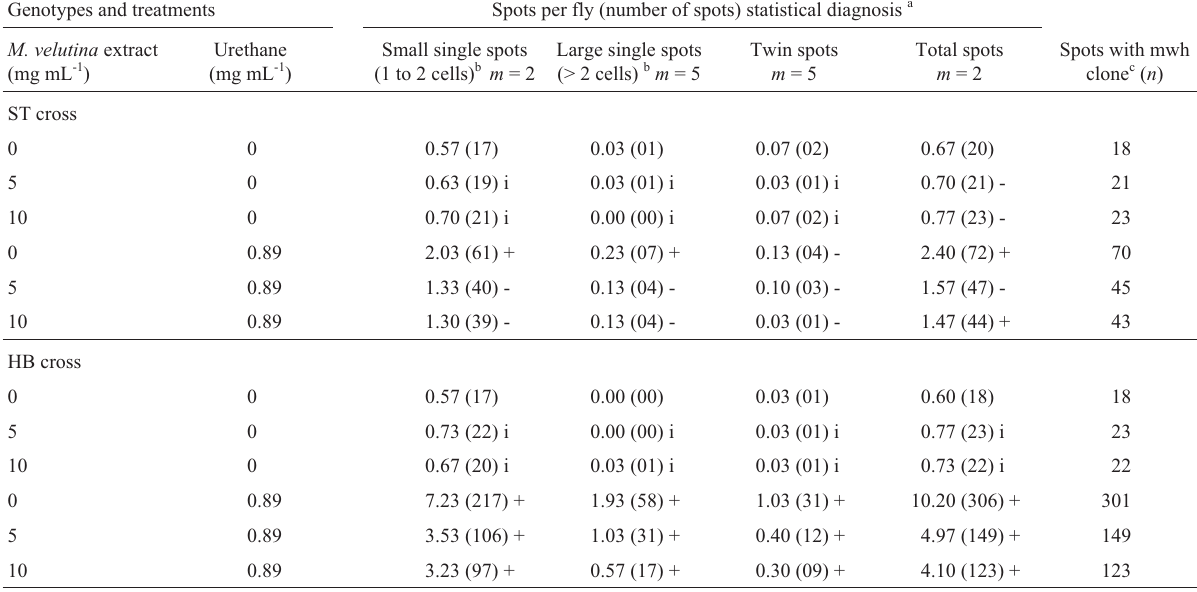
Table 2 - The D. melanogaster wing spot somatic mutation and recombination test (SMART) results showing the number of flies and frequency of spots observedinthemarker-heterozygous(MH)progenyofthestandard(ST)andthehighbioactivation(HB) D.melanogaster crossesafterchronictreatment oflarvae(n=30pertreatment)withdifferentconcentrationsof Mandevillavelutina crudeextract(CE)eitheraloneorsupplementedwith0.89mgmL -1 of urethane. Marker-heterozygous flies ( mwh/flr 3 ) were evaluated. Genotypes and treatments Spots per fly (number of spots) statistical diagnosis a